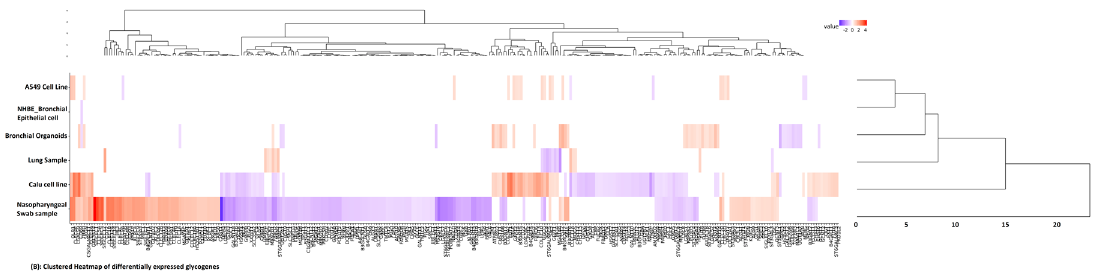
Figure 1. ( A ) Bar chart representing the categorization of the differentially expressed glycogenes identified from the 6 SARS-CoV-2 transcriptomic datapoints. The graph is generated using the GraphPad Prism 5 software. ( B ) Clustered heatmap generated using the Heatmap w ggplot (Galaxy version 2.2.1). Using a blue-white-red coloring scheme, clustering is performed using the default maximum similarity measure and the complete hierarchical clustering measure. The row labels represent the significantly differentially expressed glycogenes (with ≥ 1.5-fold change) form 6 datapoints identified from the SARS-CoV-2 infected human cell lines, organoids, ex vivo lung and nasopharyngeal samples.